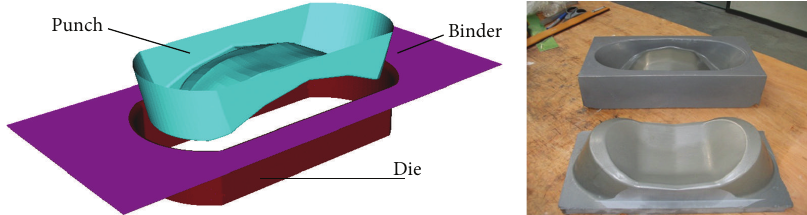
F 20: CAD and experimental tools of composite stamping.